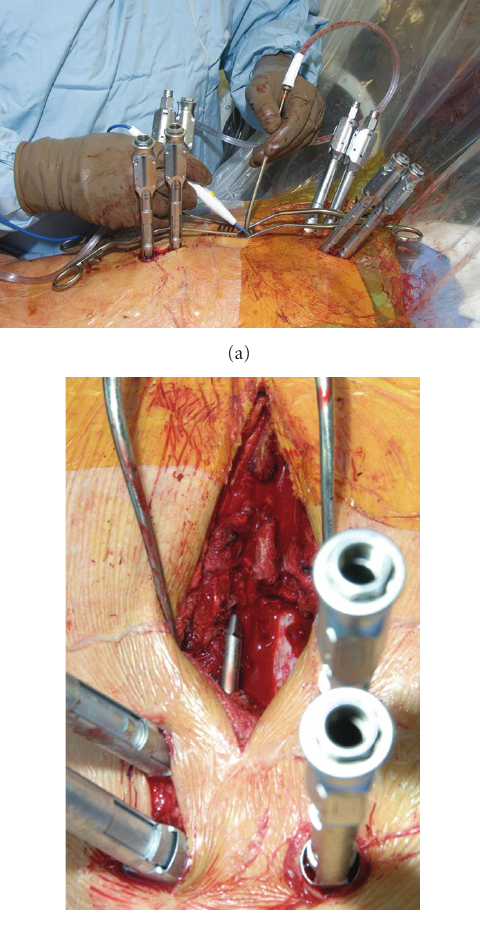
Figure 3: Miniopen decompression combined with percutaneous instrumentation. (a) Limited open decompression; (b) view of decompressed dural tube during rod passage.